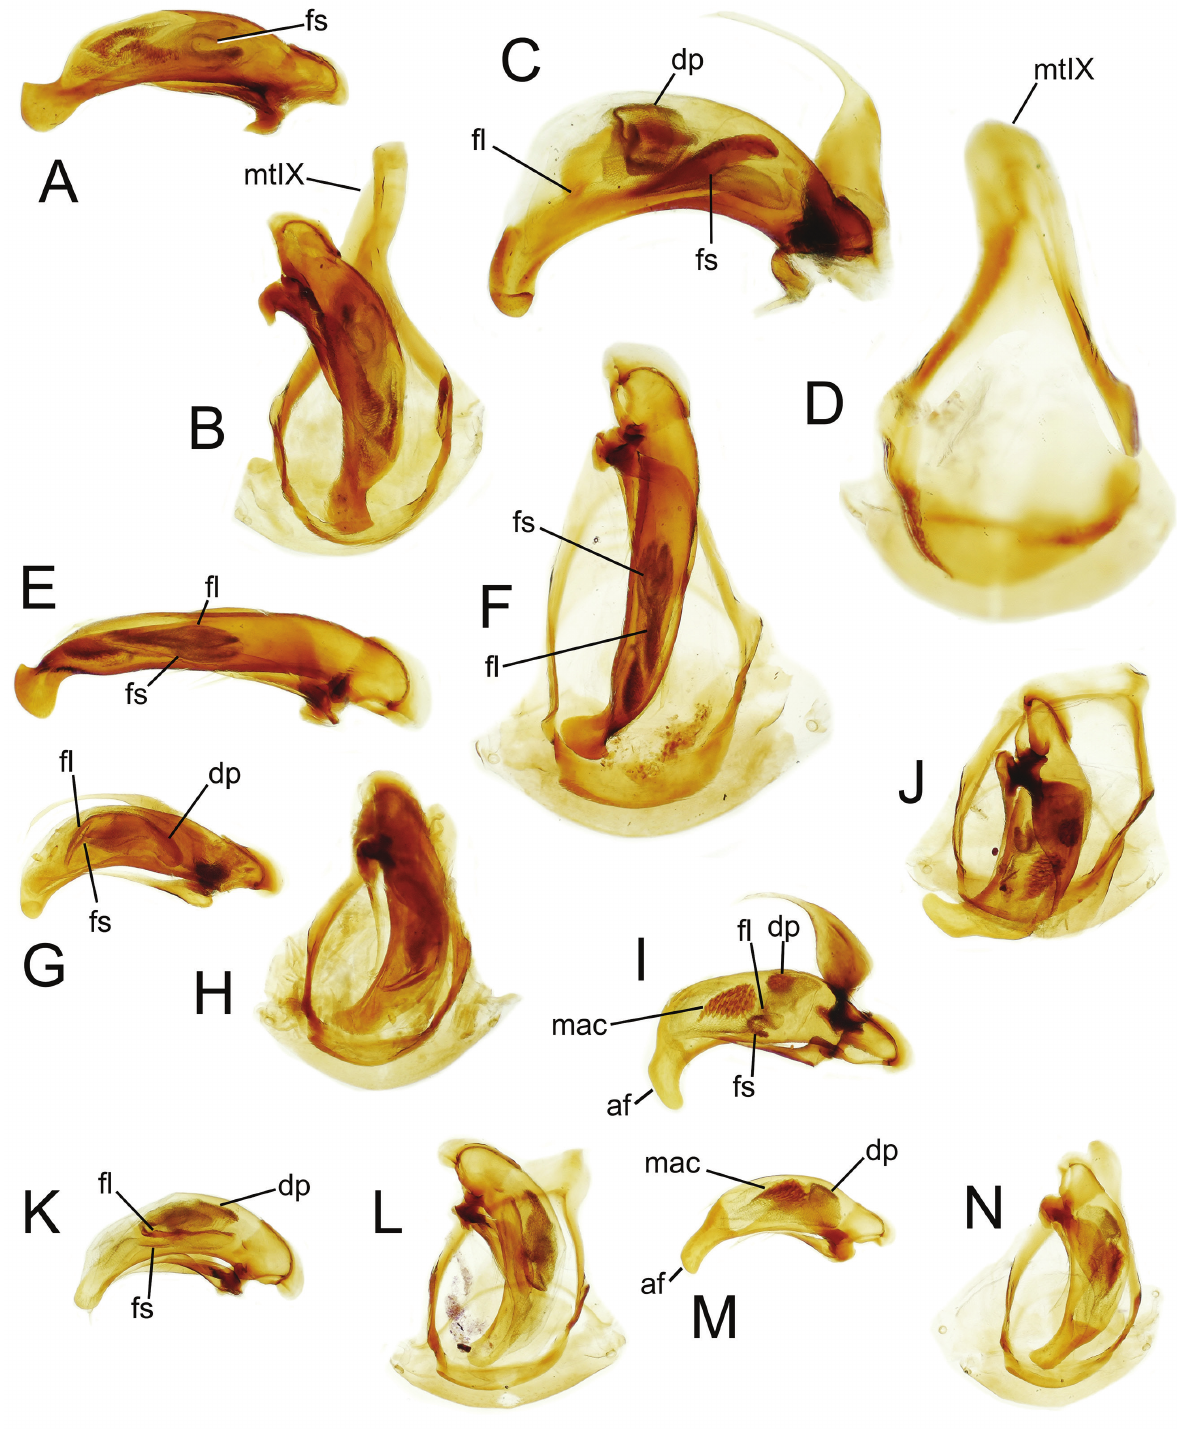
Figure 17. Male aedeagal median lobe and parameres, and ring sclerite–mediotergite plus antecostal margin, tergite IX–of Mecyclotho- rax ( Phacothorax ) spp.: A–B , M. plurisetosus , right view, dorsal view in situ (Aoupinié); C–D , M. megalovatulus , right view, dorsal view of righ sclerite (Mt. Panié); E–F , M. octavius , right view, dorsal view in situ (Me Maoya); G–H , M. laterovatulus , right view, dorsal view in situ (Aoupinié); I–J , M. manautei , right view, dorsal view in situ (Mt. Humboldt, 1400 m); K–L , M. paniensis , right view, dorsal view in situ (Mt. Panié); M–N , M. mouensis , right view, dorsal view in situ (Mt. Mou). See Table 2 for abbreviations.